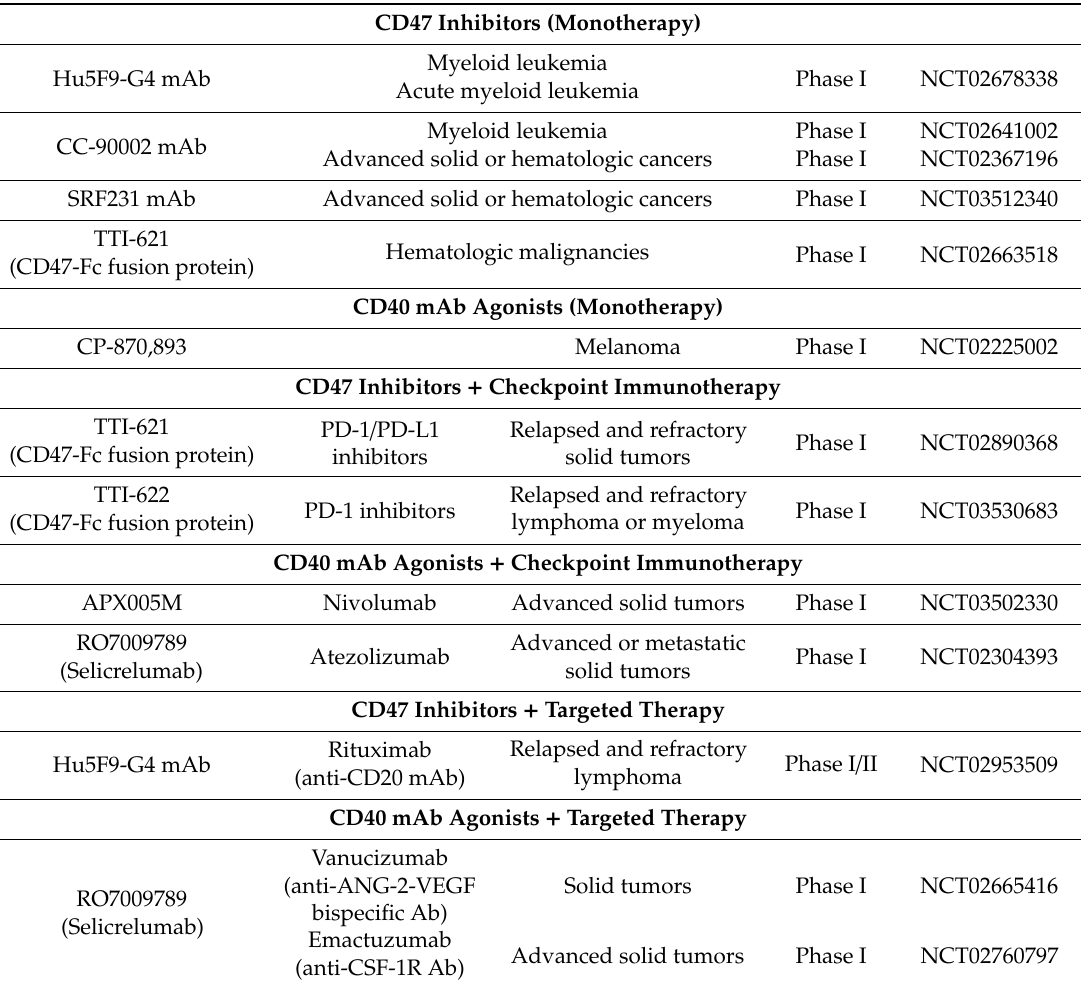
Table 2. Summary of clinical trials to reprogram TAMs, also in combination with other anti-tumor